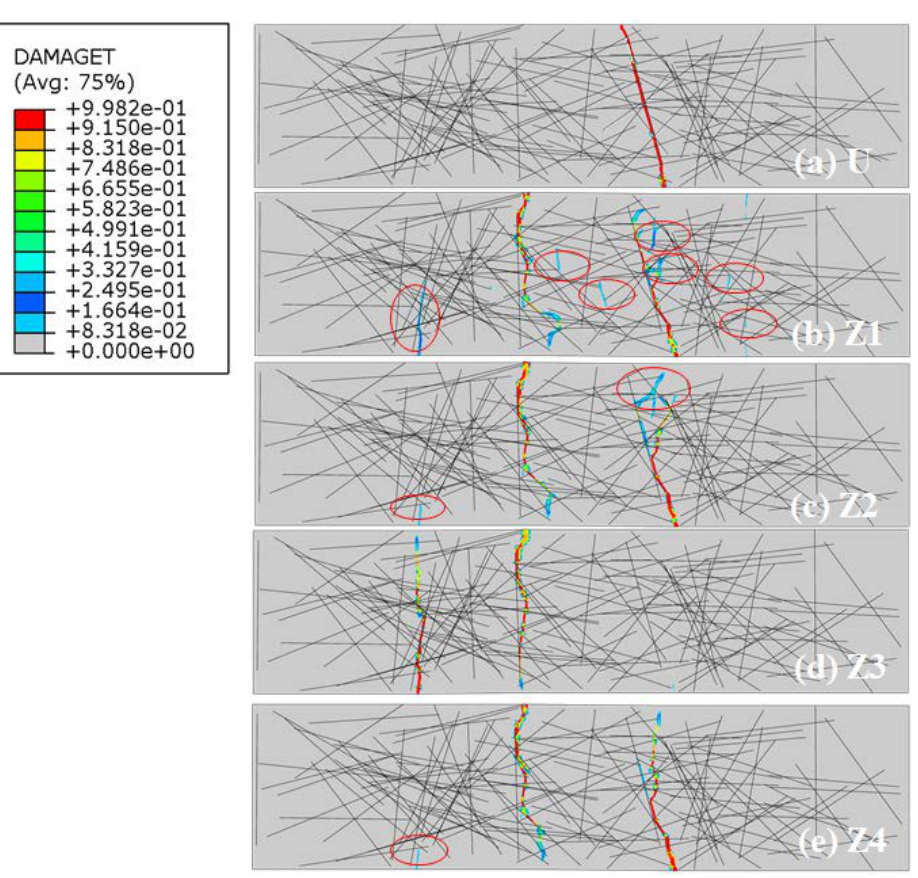
Figure 26. Failure patterns of SFRC samples with different coatings under uniaxial tension.